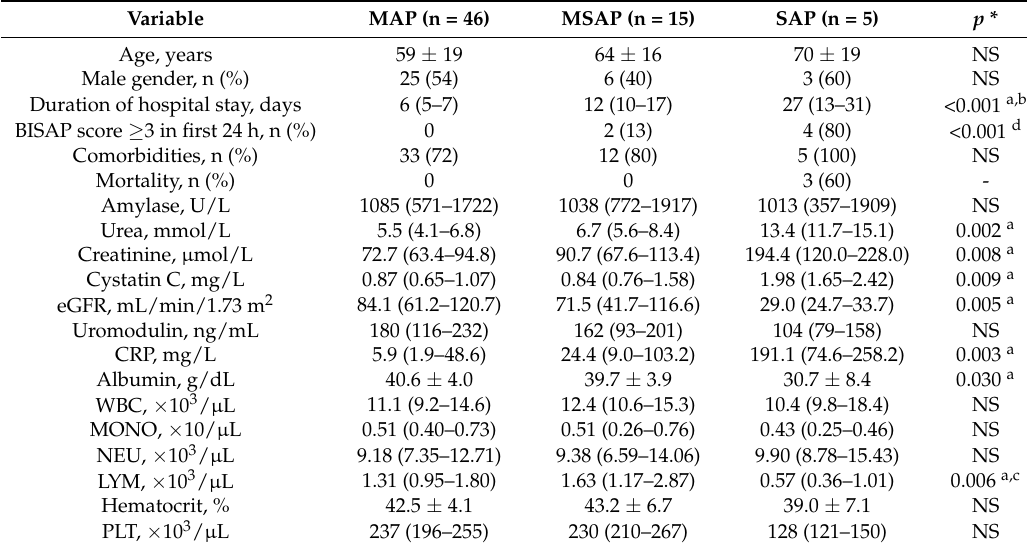
Table 1. Clinical characteristics of patients with acute pancreatitis and the results of laboratory tests at admission with respect to the severity of acute